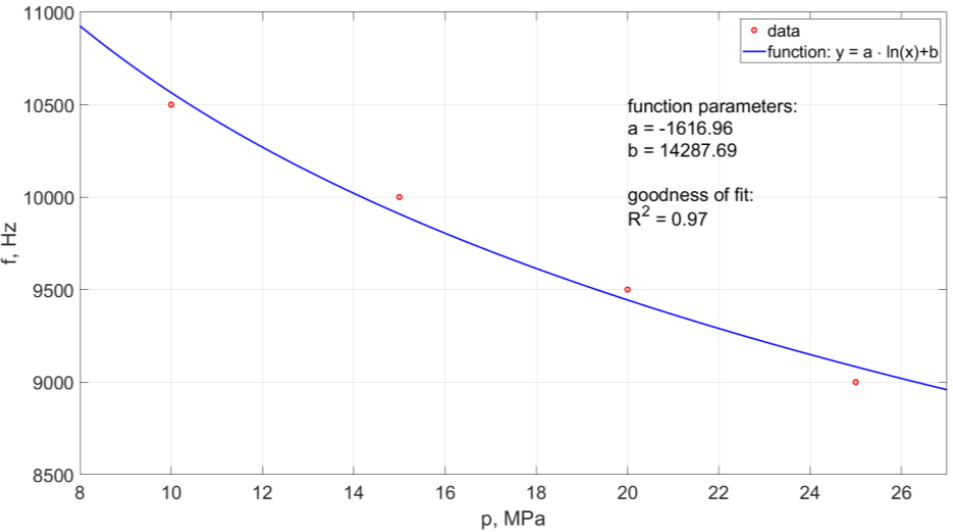
Figure 21. Influence of nominal water pressure on the pulsation frequency of the water stream generated in the head designed for drilling holes in the air environment.